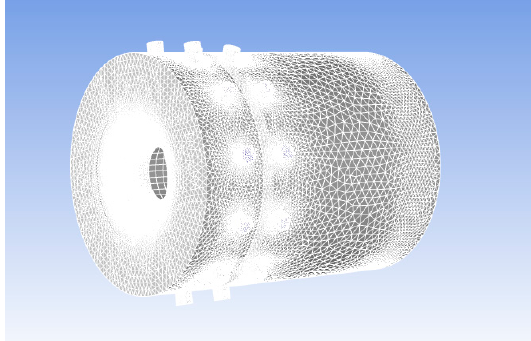
Figure 14. CFD model meshing.